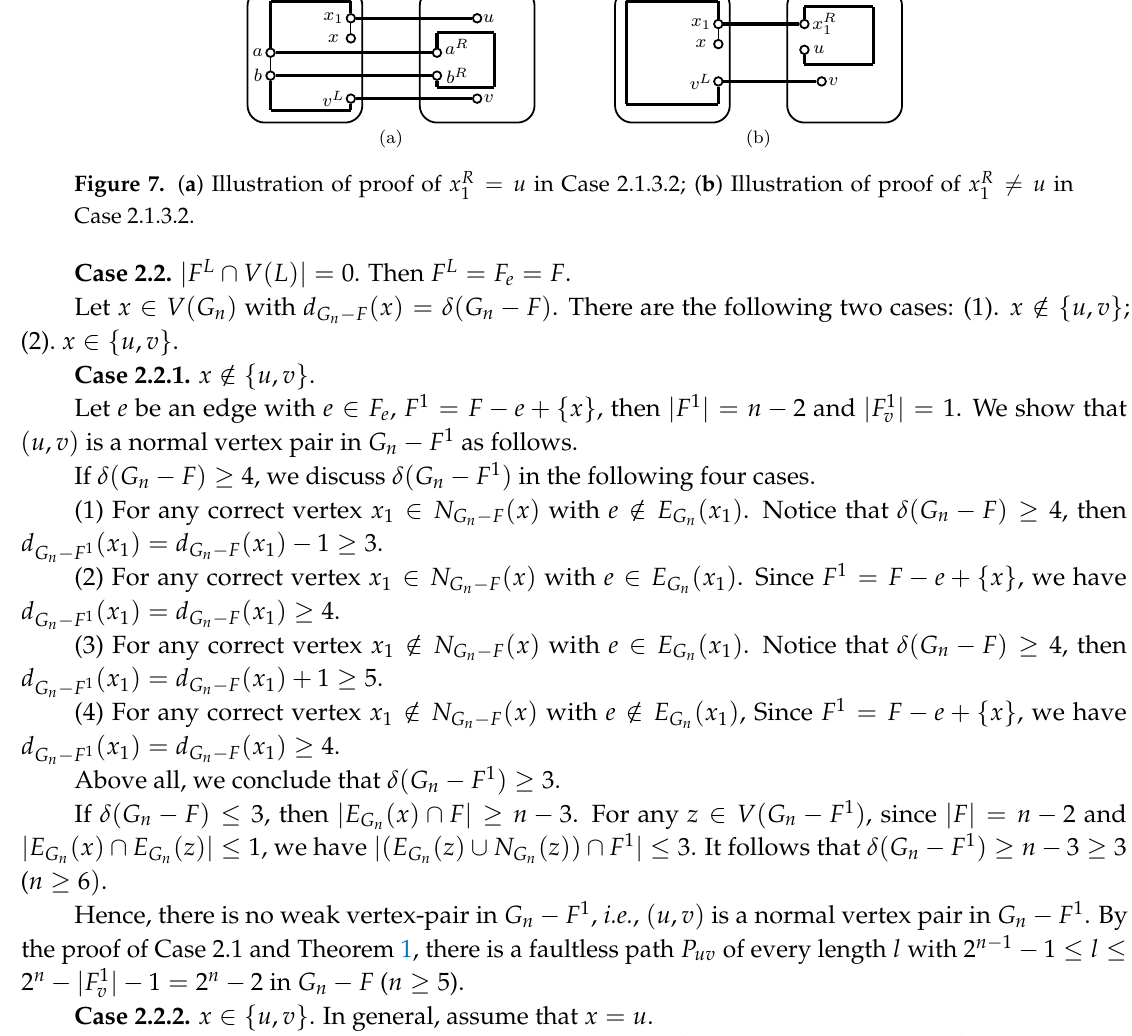
Figure 7. ( a ) Illustration of proof of x R